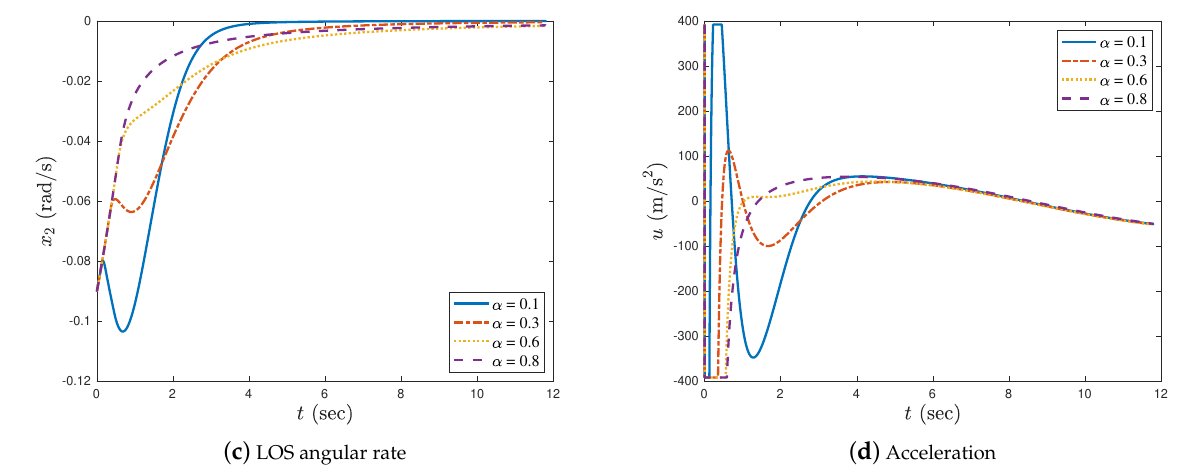
Figure 8. Simulation results with α = 0.1,0.3,0.6,0.8 in case 3.